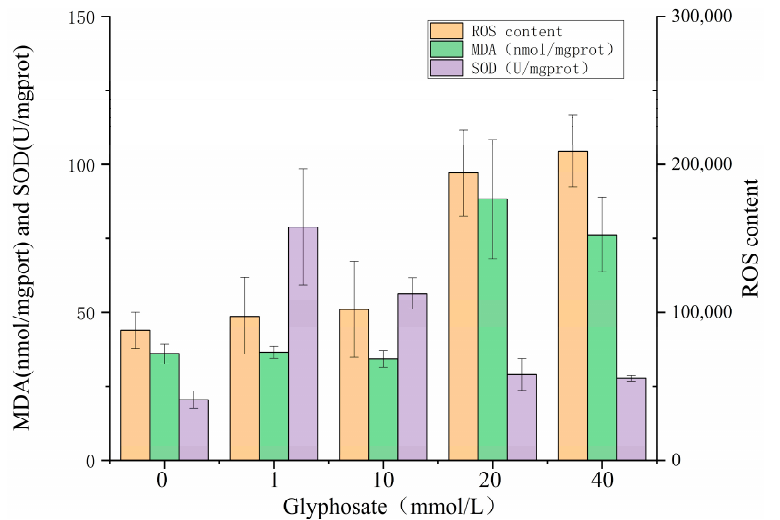
Figure 4. Effects of various concentrations of glyphosate on the antioxidant systems of Chlorella